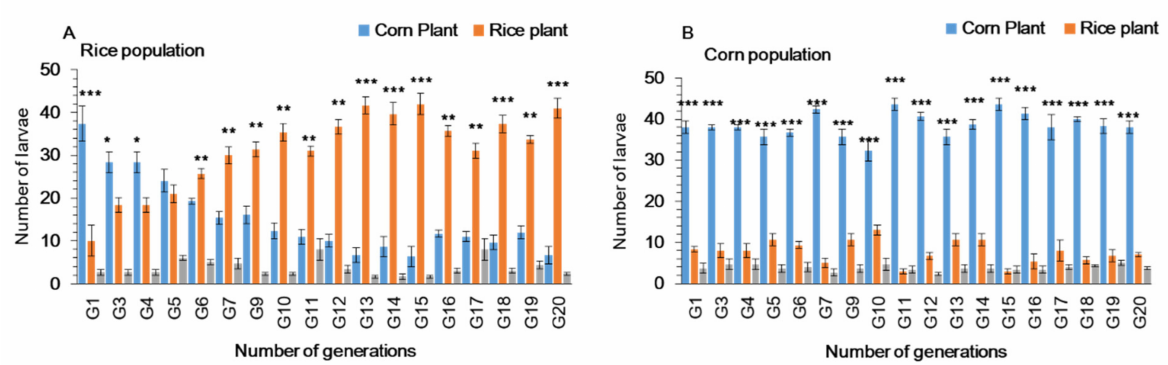
Figure 3. Feeding choice of first instars larvae of Spodoptera frugiperda in plastic cages to whole plants, when reared on ( A ) rice and ( B ) corn plants for 20 generations. Data are means ± SE. Asterisks *, ** and *** show significant differences between host plants ( p < 0.05) based on post hoc Tukey’s HSD